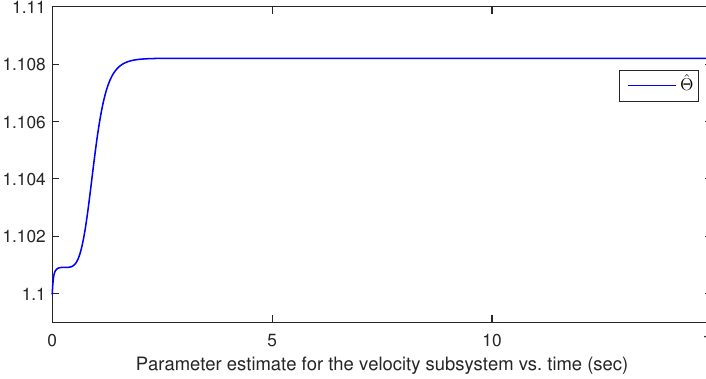
Figure 6. The parameter estimate response of the velocity